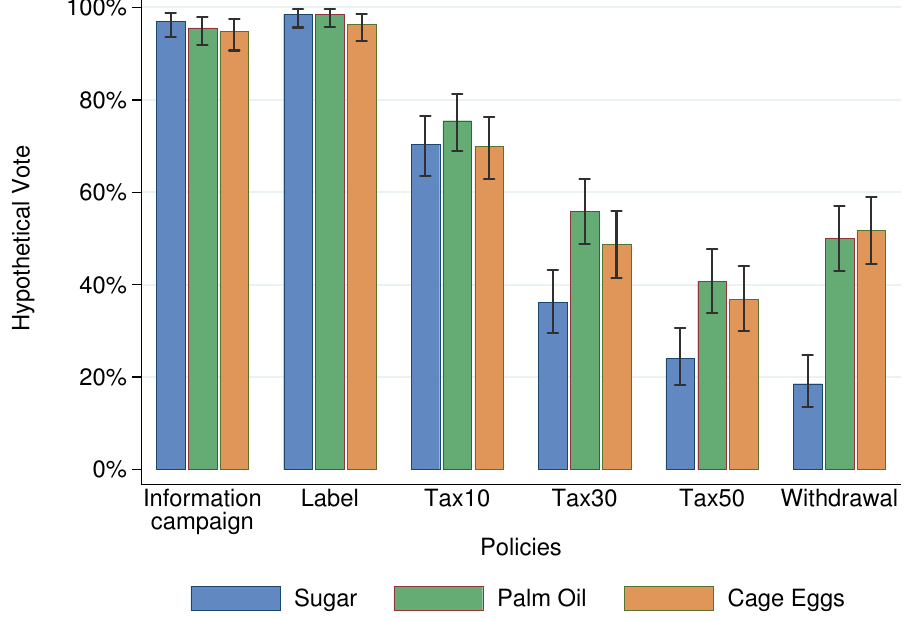
Figure A2. Hypothetical votes—confirmatory